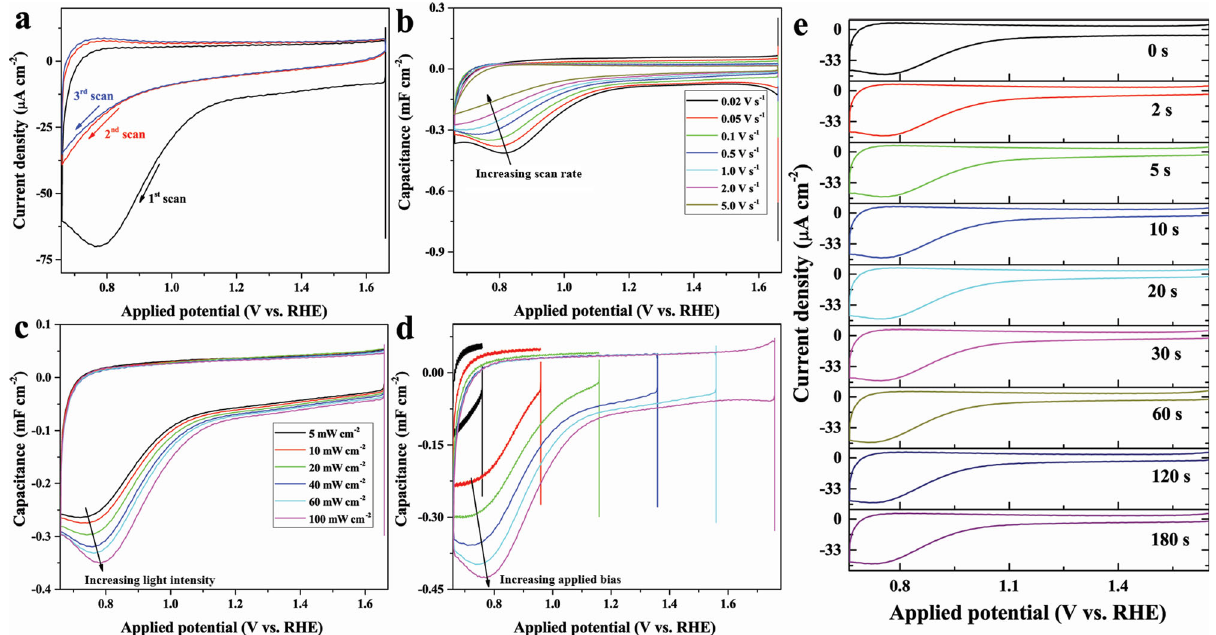
Fig. 2 Evolution and lifetimes of S1 and S2. Fast cathodic CV scans (200 mV s − 1 , otherwise separately labeled) of a representative photoanode at pH 8.0 after preconditioning at steady-state photoelectrochemical OER (100 mW cm − 2 , otherwise separately labeled) at the high potential for 1 min: comparison of different scan cycles ( a ), the capacitive plot of the fi rst CV scans measured at different scan rates ( b ), comparison of different illumination intensities ( c ), different potentials ( d ), and different waiting times under dark conditions ( e